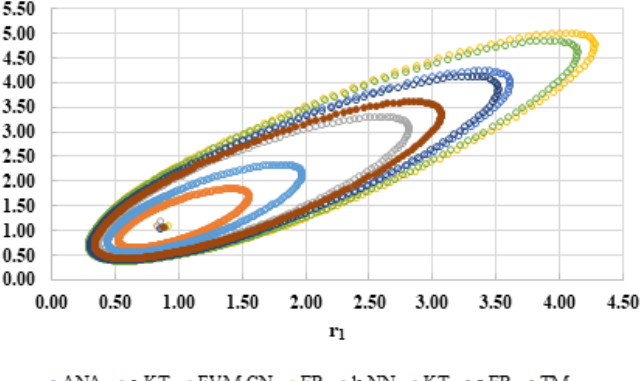
Figure 24. The JCR of analyzed methods for reactivity ratios calculation for copolymerization of NIPAM-NVP [41].